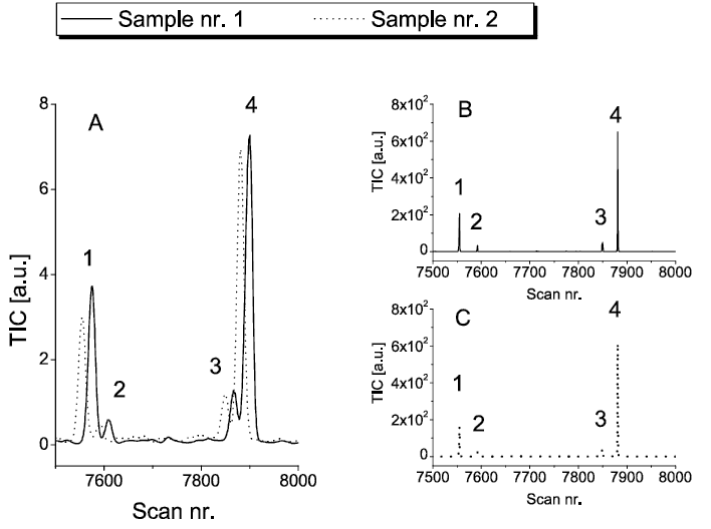
Figure 3. Impression of data pre-processing for signals that represent the concentration of (1) 2-carene, (2) α -phellandrene, (3) limonene, and (4) β -phellandrene. Provided are: (A) unprocessed data of sample nr. 1 and nr. 2; (B) baseline corrected, scaled, noise reduced and aligned data of sample nr. 1; (C) baseline corrected, scaled, noise reduced and aligned data of sample nr. 2. TIC = total ion